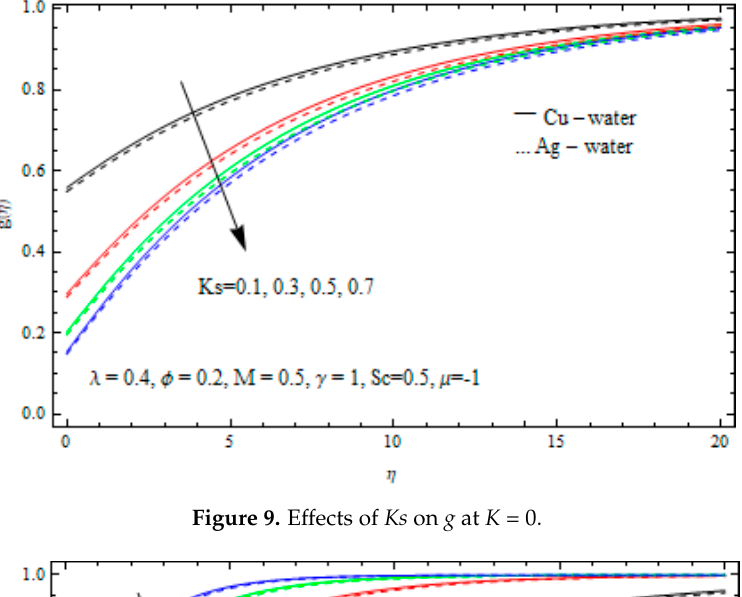
Figure 9. Effects of Ks on g at K = 0.